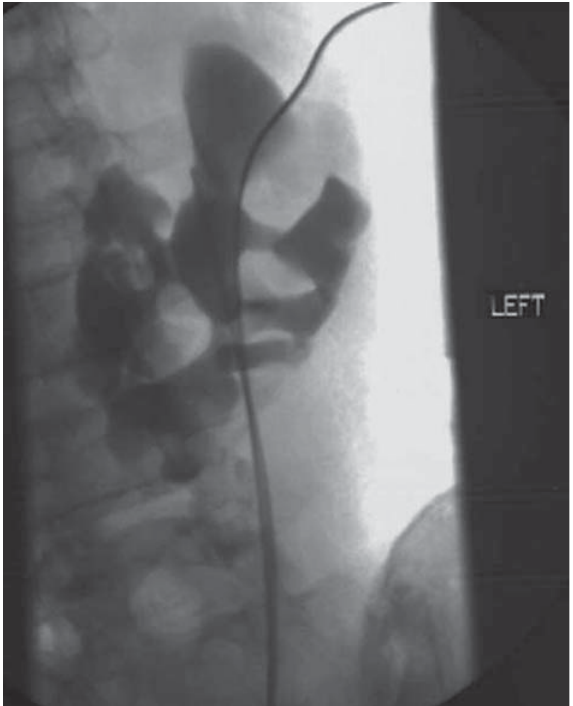
Figure 4 – The superior posterior calyx of a horseshoe kidney is easily accessed via an intercostal approach. Again, note the straight trajectory to the renal pelvis, inferior calices and ureter.